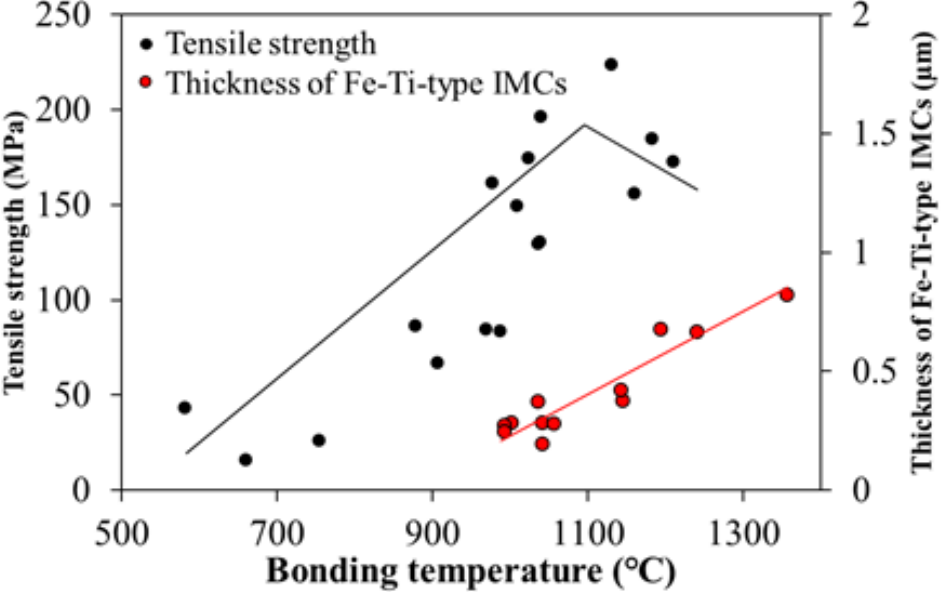
Figure 11. Effects of the bonding temperature on the tensile strength of the joint and the thickness of Fe-Ti-type intermetallic compound (IMC) layers.